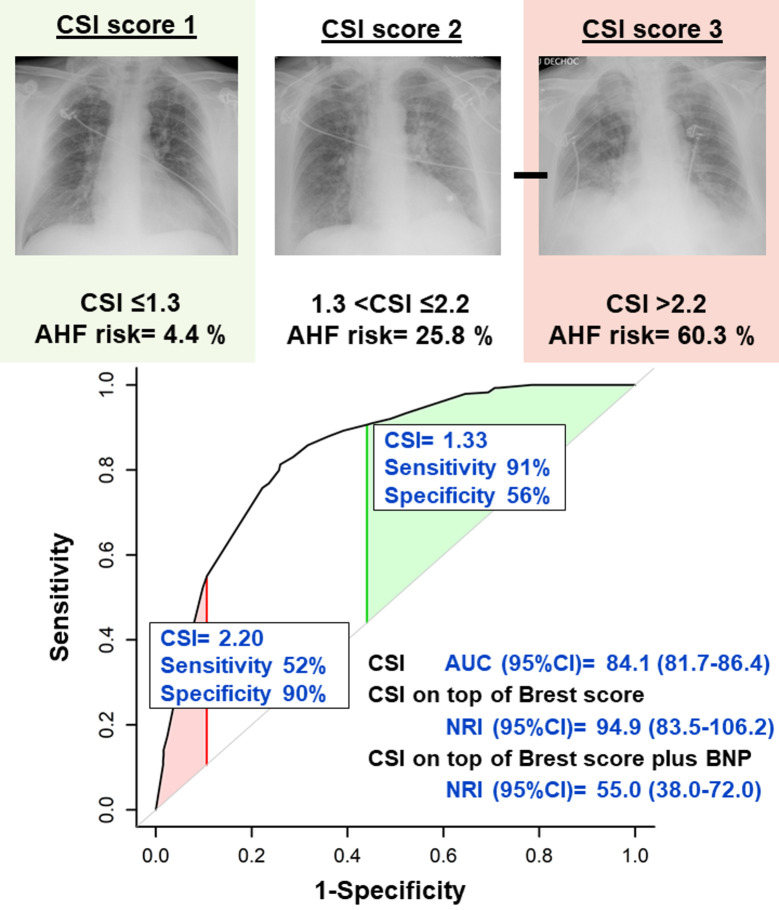
Diagnostic performance of the radiographic CSI.On the receiving operating characteristic curve for the association between CSI and AHF diagnosis, the red shaded region represents the 90% or greater specificity zone (CSI ≤ 1.3), whereas the green shaded region represents the 90% or greater sensitivity zone (CSI > 2.2). On the top portion of the figure, CXR panels illustrate typical examples of radiographies in the 3 zones, with CSI score of “1,” “2,” and “3,” respectively, from left to right. AHF, acute heart failure; AUC, area under the curve; BNP, b-type natriuretic peptide; CSI, congestion score index; CXR, chest radiography; NRI, net reclassification improvement.